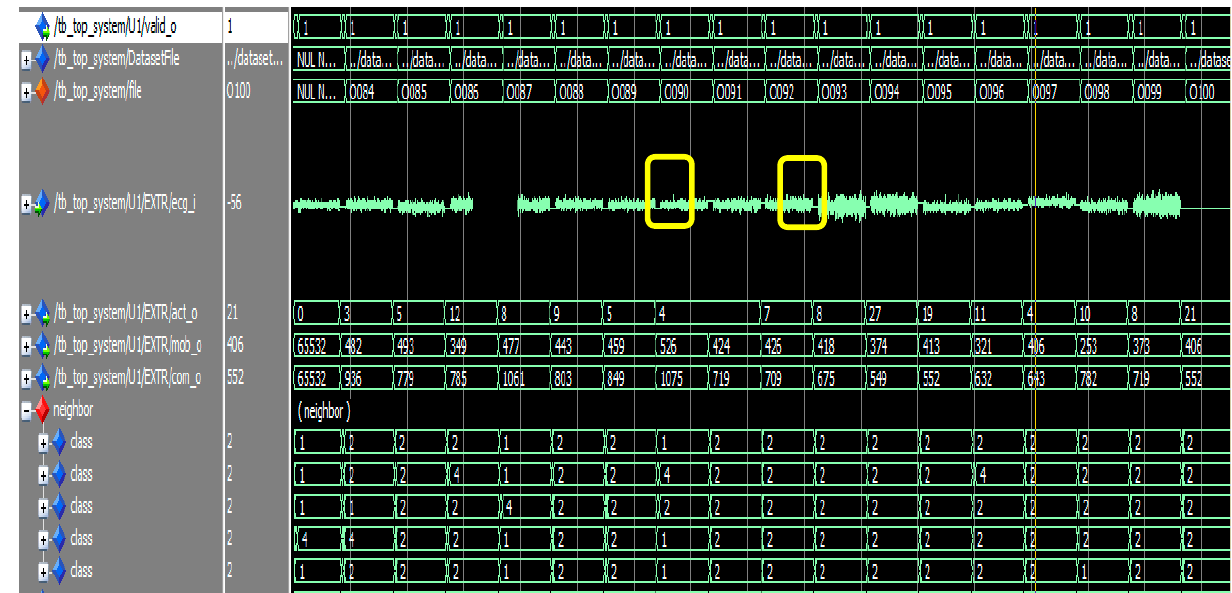
Figure 13 . Classification simulation with normal class as input. The yellow boxes show that the inputs are wrongly classified because the closest neighbor comes from the interictal (1) class.